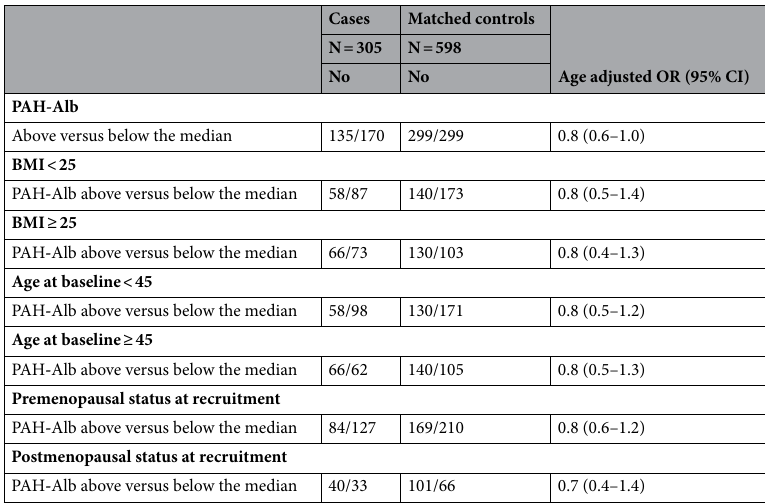
Cases Matched controls